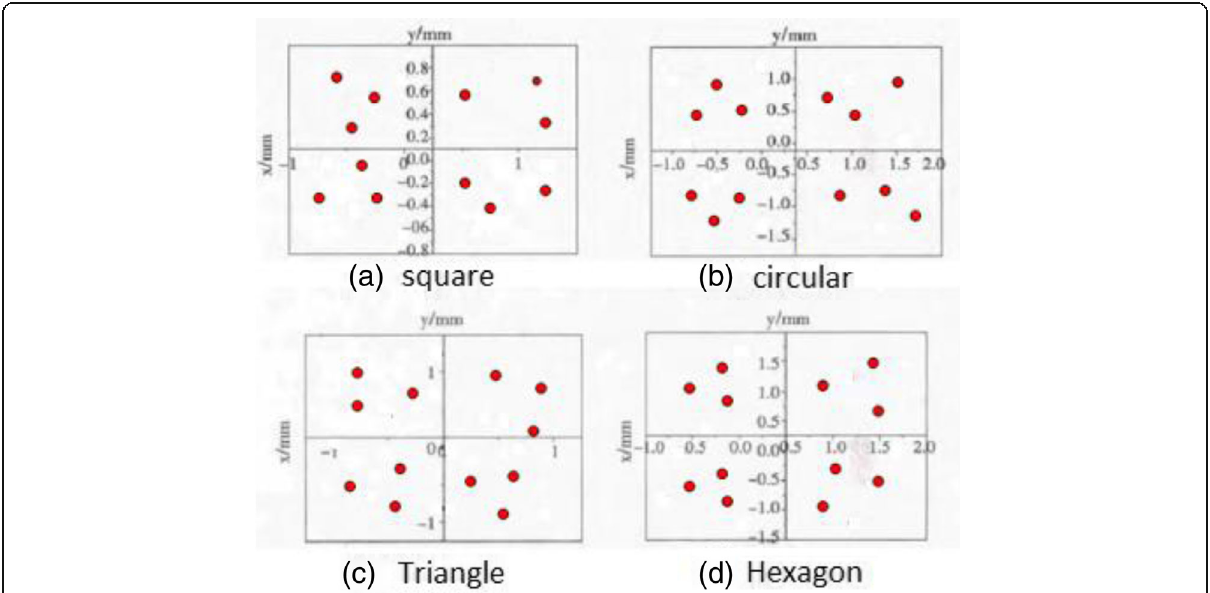
Fig. 6 Regular quadrilateral, circular, regular triangle, and regular hexagon grab central points respectively